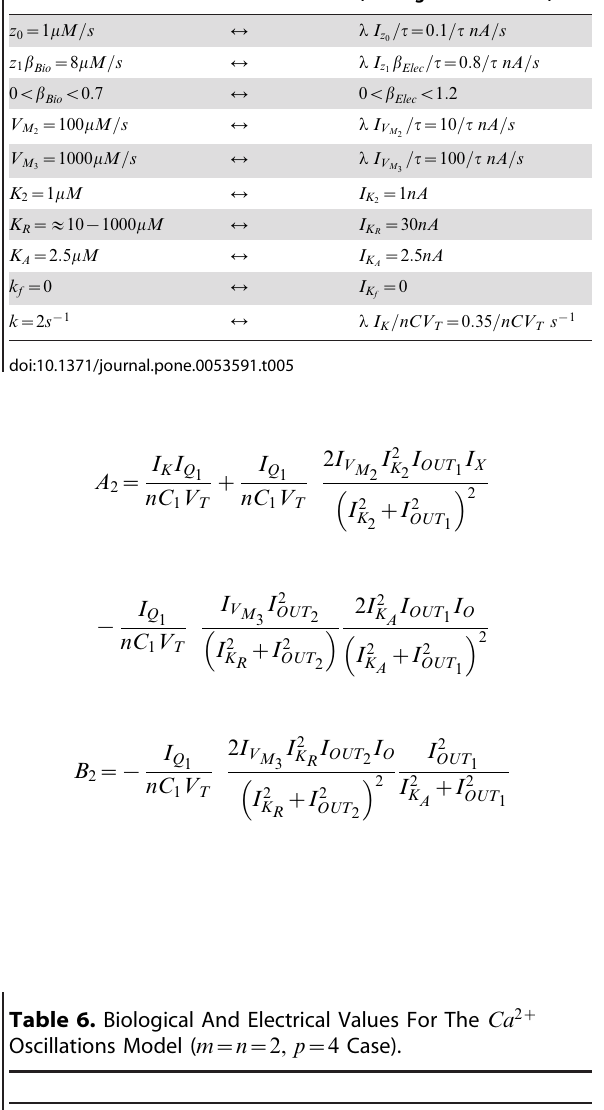
(Scaling Factor l : 50%)